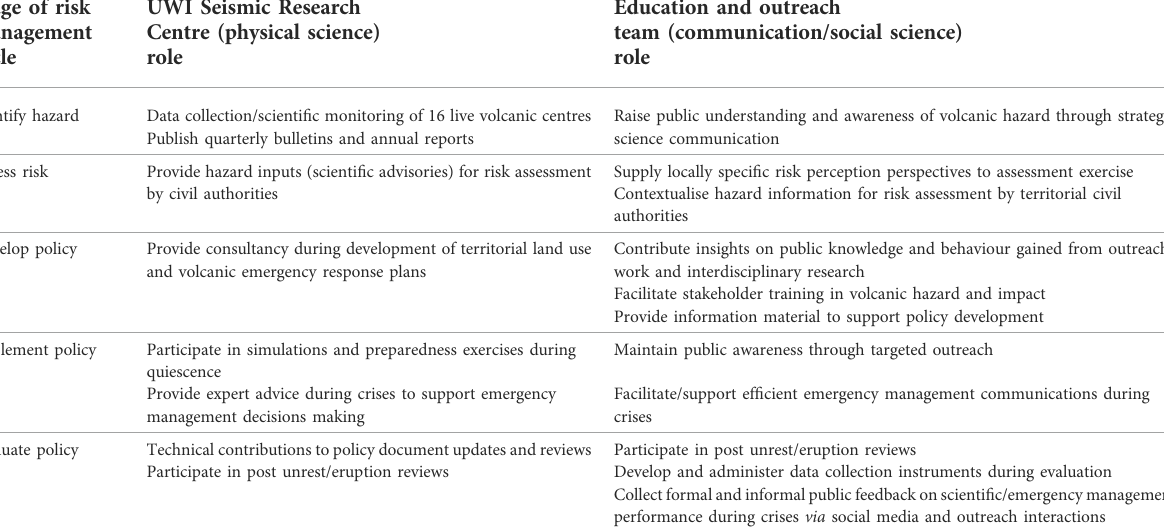
TABLE 1 Roles for physical and communication/social science at The UWI Seismic Research Centre throughout the risk management